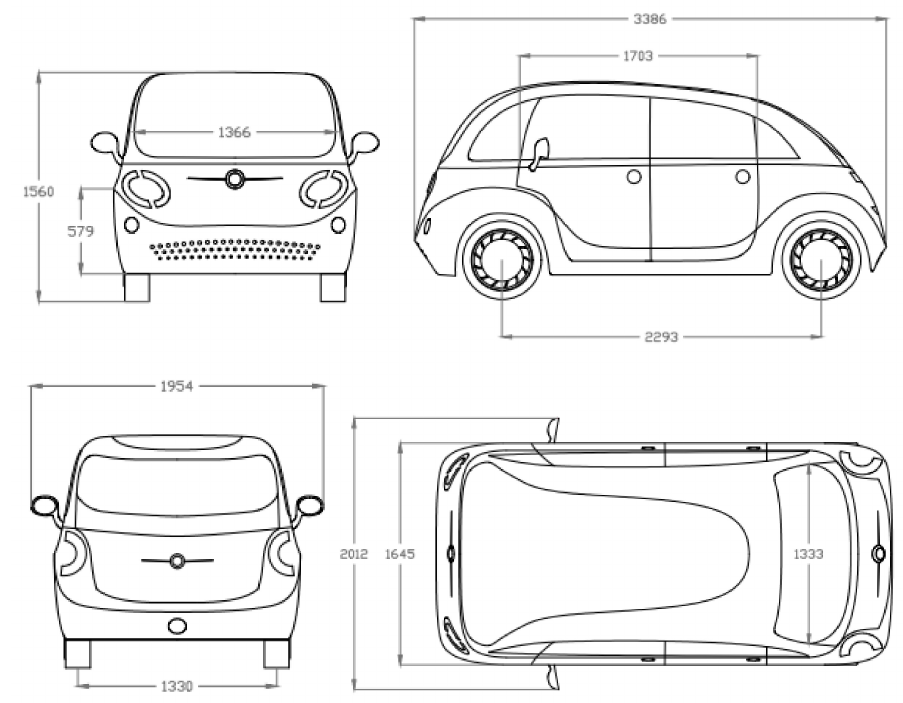
Figure 25. New FIAT 600 Omega—Disegni 2D.